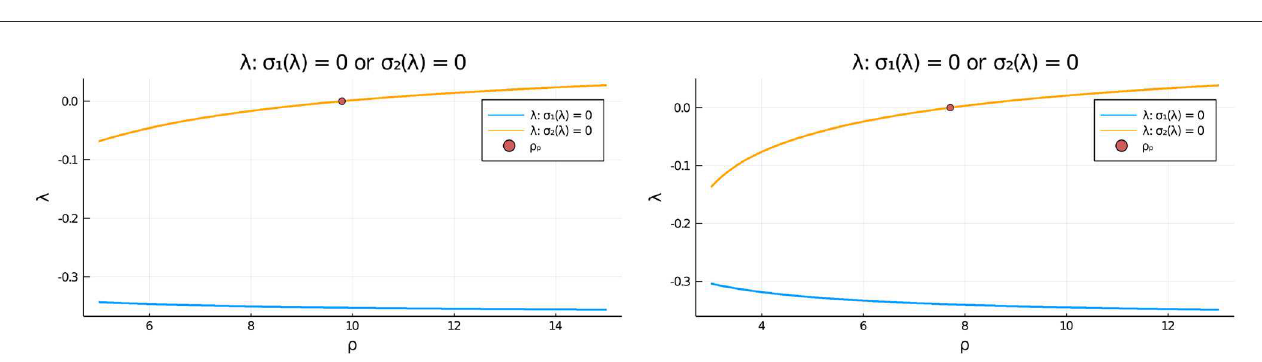
6.27945 and the subcritical pitchfork point ≈ D v 5, σ u 0.6, d u 0.05, ε 0.03, and r 0.5. σ v = = = = = = =